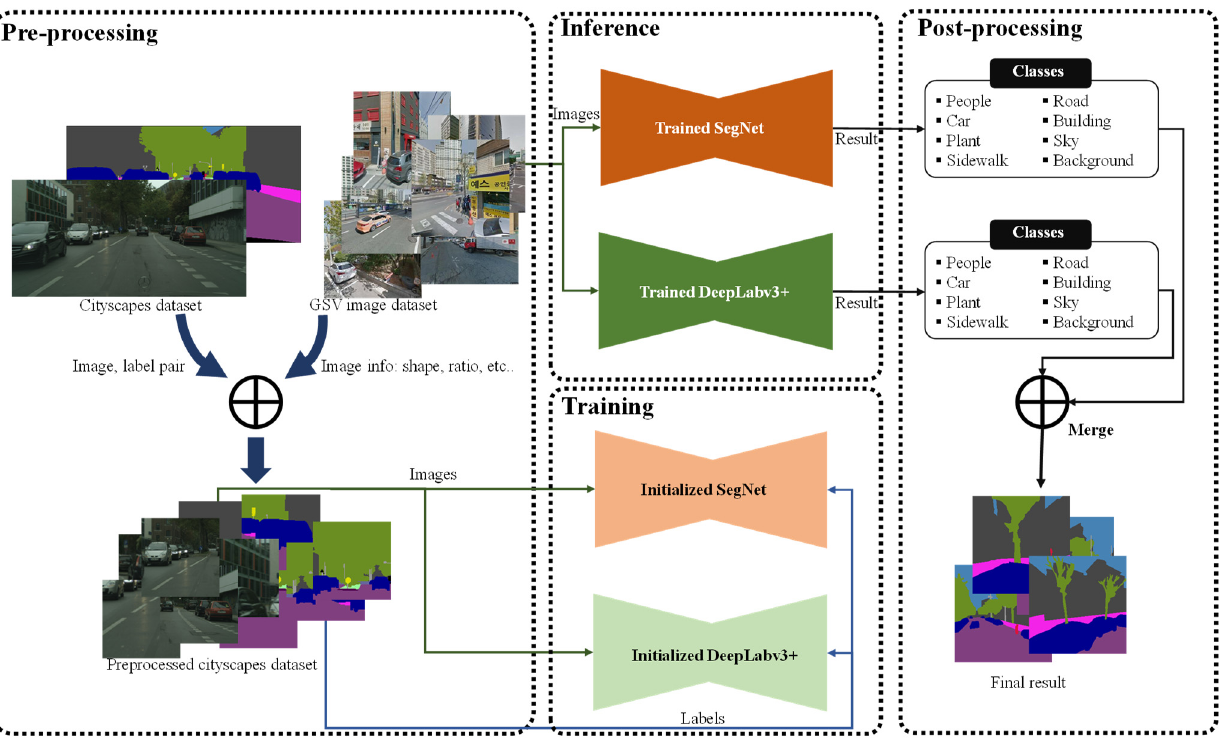
Figure 1. Overall fl